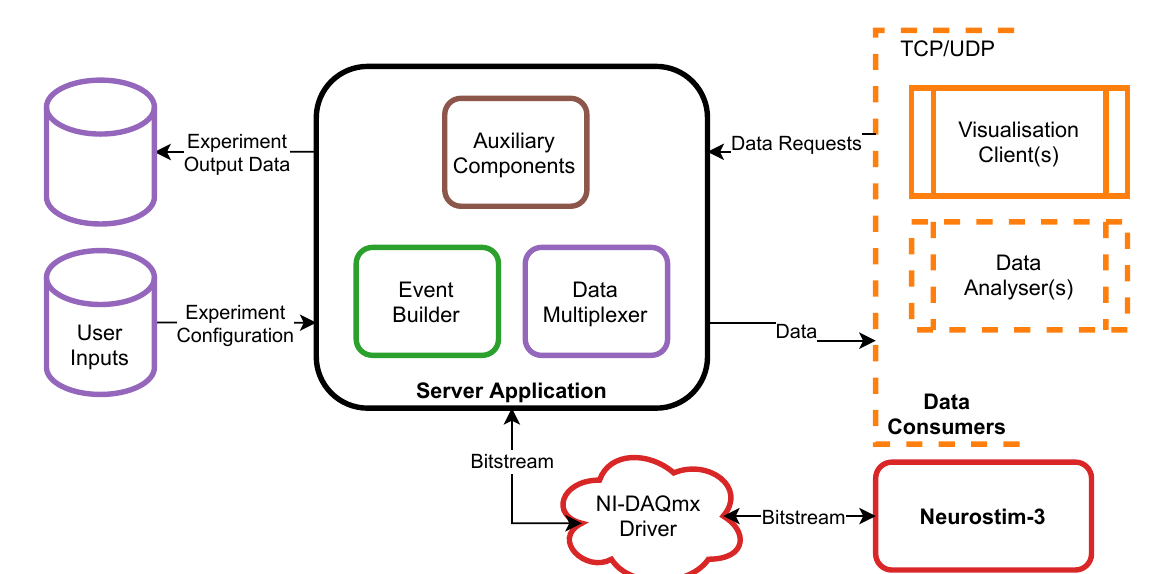
Figure 5. Schema of the core system architecture with the Server Application being its central part. Server Application is mainly responsible for (1) Output Bitstream creation based on the user-specified Experiment Configuration , (2) two-way communication with the NI DIO 6537 card which transfers data between the Server and Neurostim-3 ASICs, (3) extraction of meaningful per channel data from the Input Bitstream , (4) saving data onto permanent storage device (5) and further data distribution to compatible host applications via Transmission Control Protocol (TCP) or User Datagram Protocol